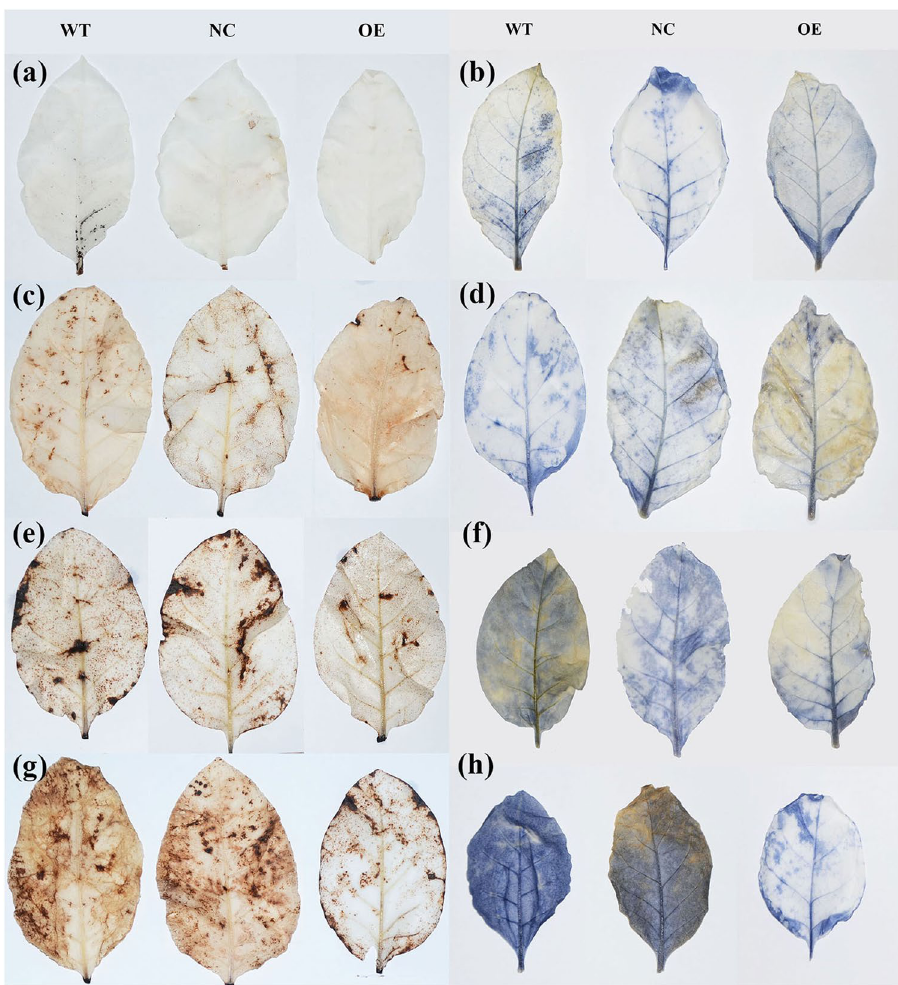
Figure 5. ROS staining of 35 S::N41 (OE), wild type (WT) and NC (negative control) tobacco plants under increasing drought stress levels. ( a - b ) Plants with non-treatment; ( b - c ) plants under light drought (soil water content: 8–10%); ( e - f ) plants under medium drought (soil water content: 3–5%); ( g - h ) NC, OE and WT plants under severe drought (soil water content: <